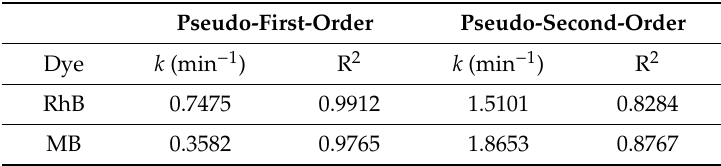
Table 4. The results of pseudo-first-order and pseudo-second-order kinetic model of RhB and MB dye reduction by C. pentandra / Ag-NPs.